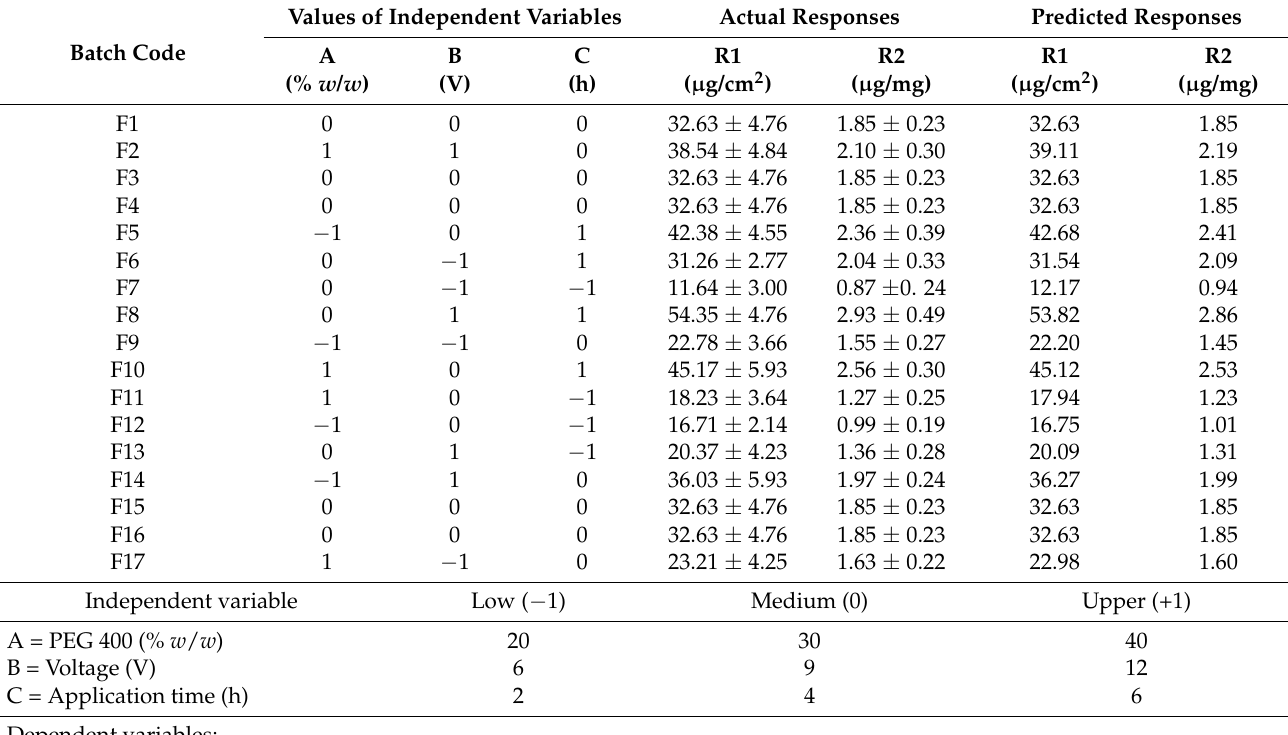
Table 3. Representation of levels of independent variables based formulation details (F1–F17) with data of actual and predicted responses in Box–Behnken design.